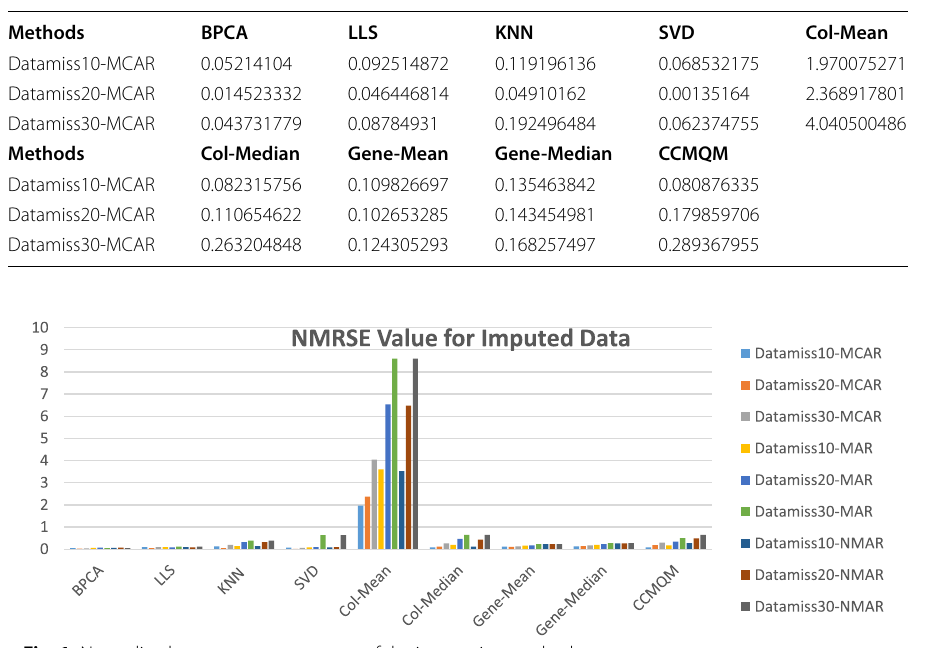
Table 1 Sample table of normalized root mean square errors